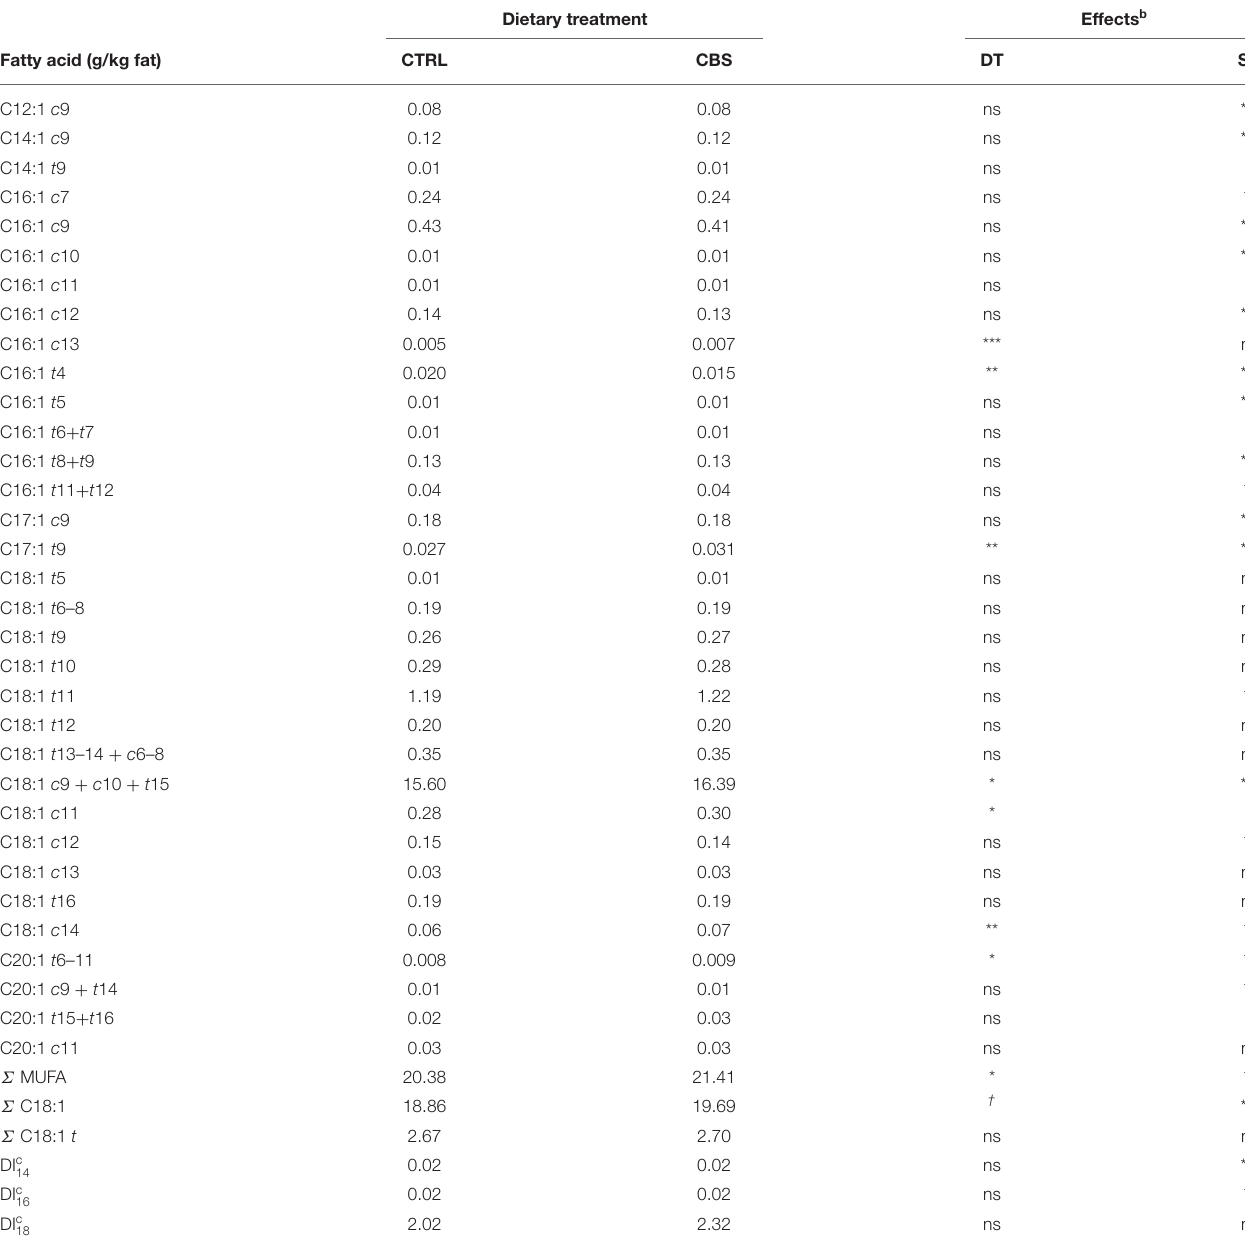
TABLE 5 | Monounsaturated fatty acids (g/kg fat) in milk of goats fed the control (CTRL) and cocoa bean shell (CBS) diets a . Dietary treatment Effects